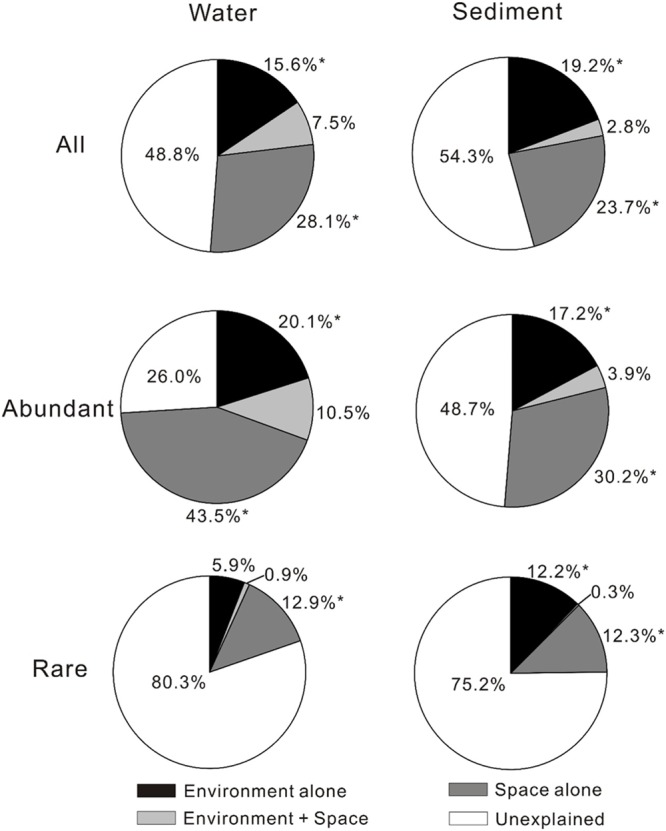
Variance partition analysis showing relative importance of environmental and spatial factors in shaping microbial community compositions (MCCs) in the lake waters and sediments of the studied lakes (The significances were tested by canonical correspondence analysis (CCA) with 1000 permutations).
∗P < 0.05.